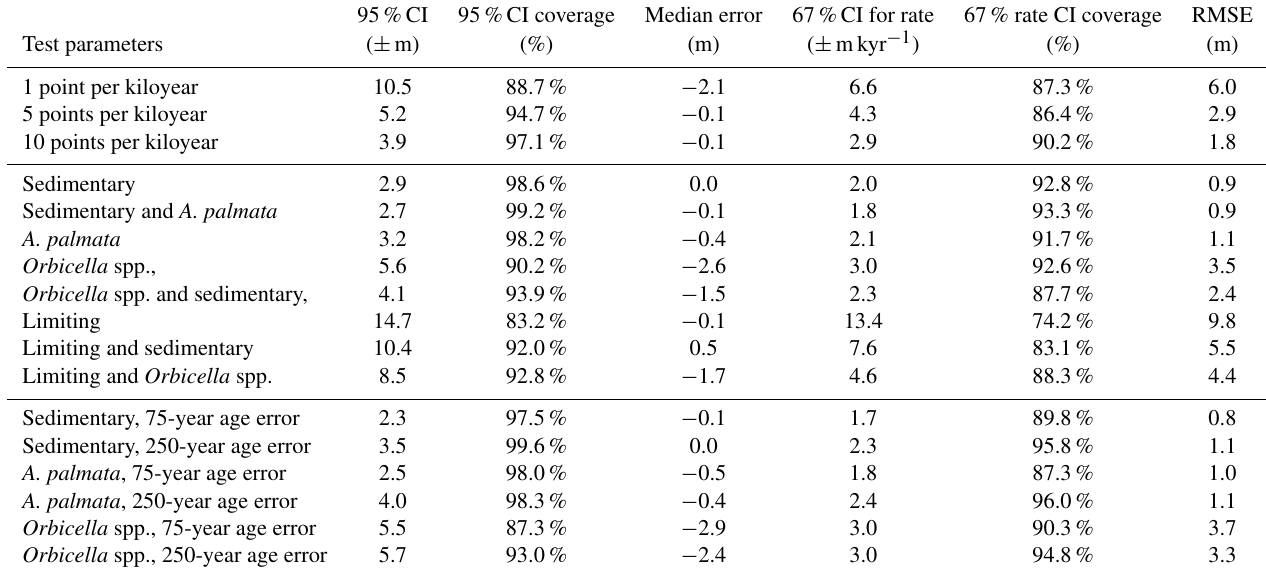
Table D5. Sensitivity test results for sea-level curve 1